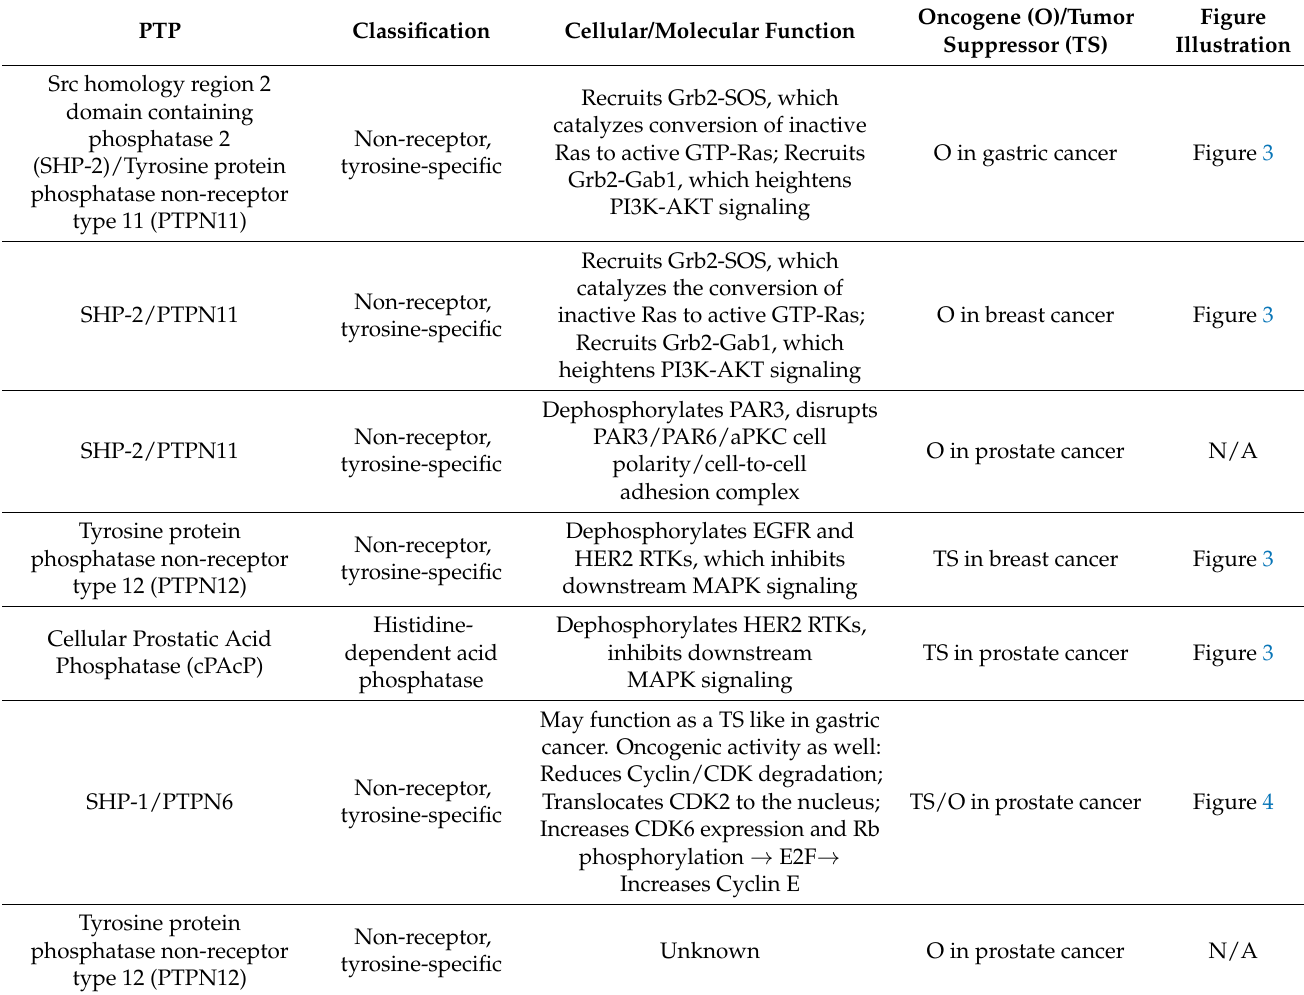
Table 3. PTPs that affect RTK-associated PI3K-AKT and Ras-Raf-Mek-Erk Signaling.